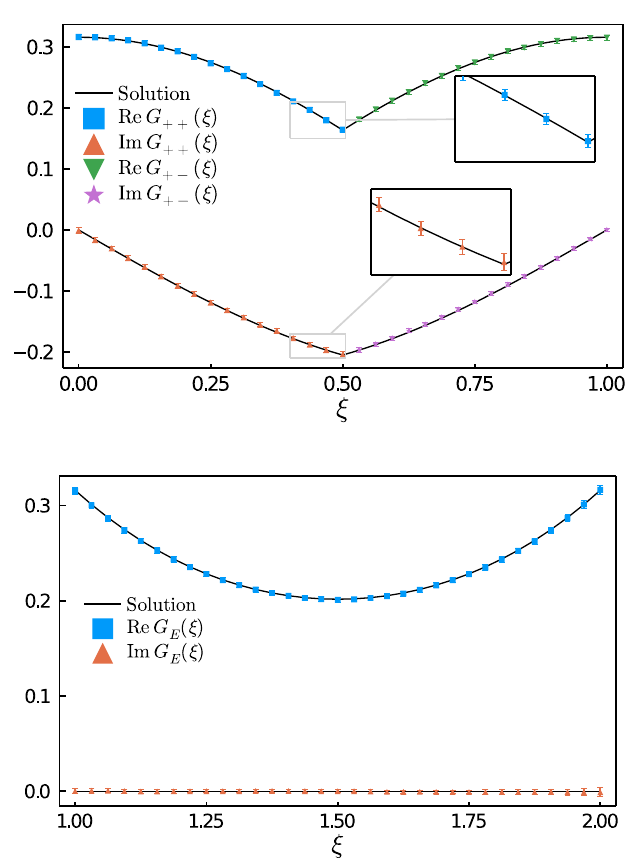
Figure 6 . (Top) Two unequal time correlation functions along the real-time branches of the canonical Schwinger-Keldysh contour. For ξ < 1 / 2 the datapoints represent G ++ ( x 0 = ξ ) = h φ (0) φ ( ξ ) i − h φ (0) ih φ ( ξ ) i and for ξ > 1 / 2 we have G + − ( x 0 = 1 − ξ ) = h φ (0) φ ( ξ ) i − h φ (0) ih φ ( ξ ) i . Note the excellent accuracy in reproducing the continuous Langevin time result given as black solid line. (bottom) The Euclidean correlator G E ( x 0 = − i ( ξ − 1)) = h φ (0) φ ( ξ ) i evaluated on the imaginary time branch of the canonical Schwinger-Keldysh contour together with the continuous Langevin time solution (black